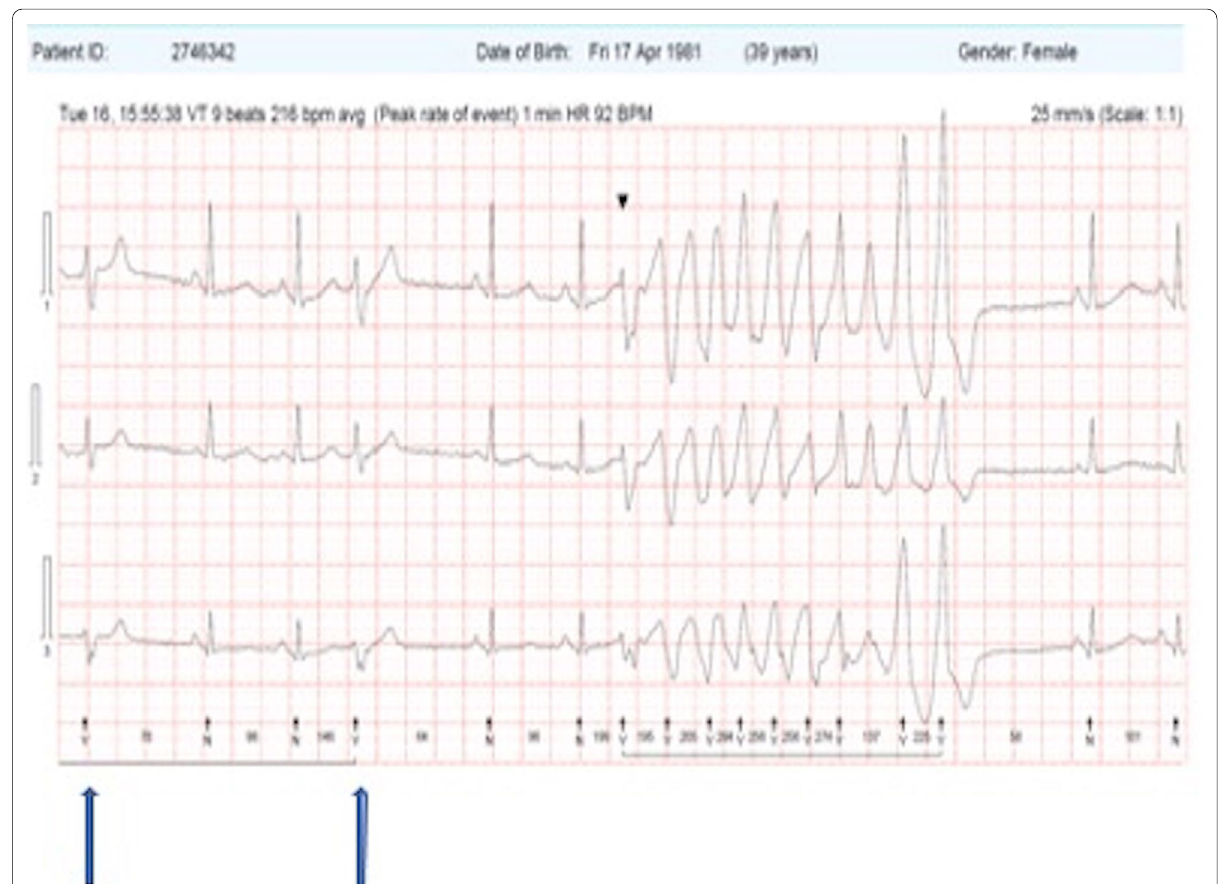
Fig. 4 Short-coupled VE (coupling interval 310 ms, on the peak of the T wave) leading to non-sustained polymorphic VT in a 3-lead ECG. Compare to the first two VEs (see arrows) on the same tracing, which are much-later coupled and trigger no such